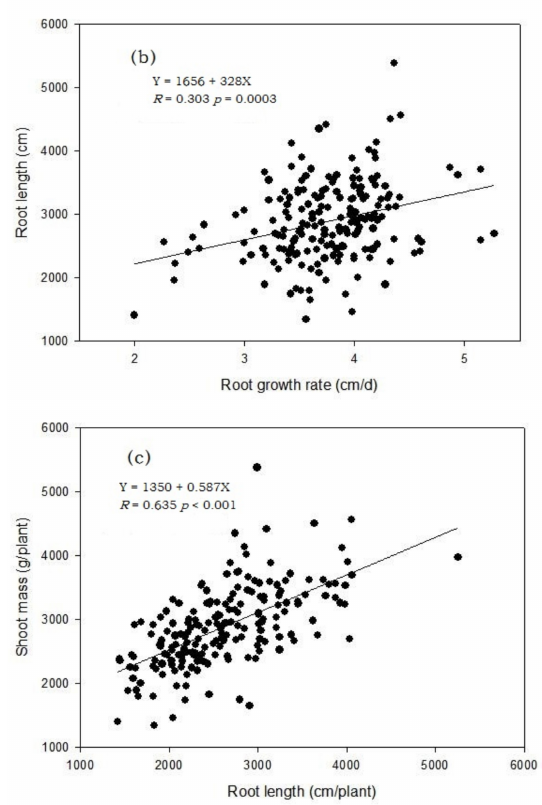
Figure 3. Correlation between shoot dry mass and root dry mass (both log-transformed) ( a ), root length and root growth rate ( b ) and root length and shoot dry mass ( c ) of 189 barley genotypes grown in the semi-hydroponic phenotyping system for 30 days after transplanting in a temperature- controlled glasshouse (n = 3).